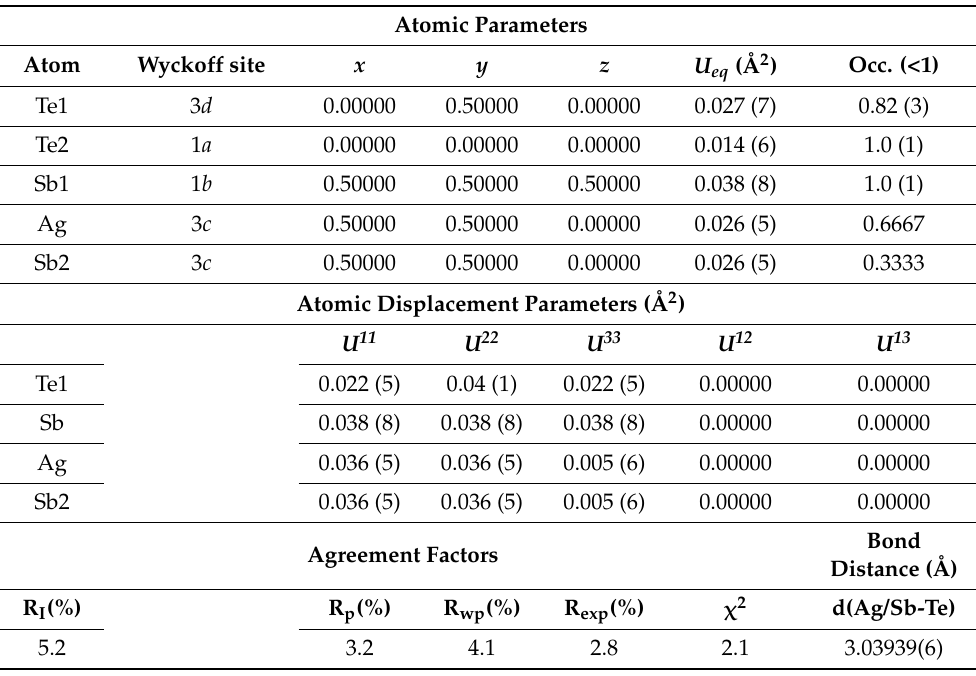
Table 2. Structural parameters obtained from the refinement of the NPD data of AgSbTe 2 at room